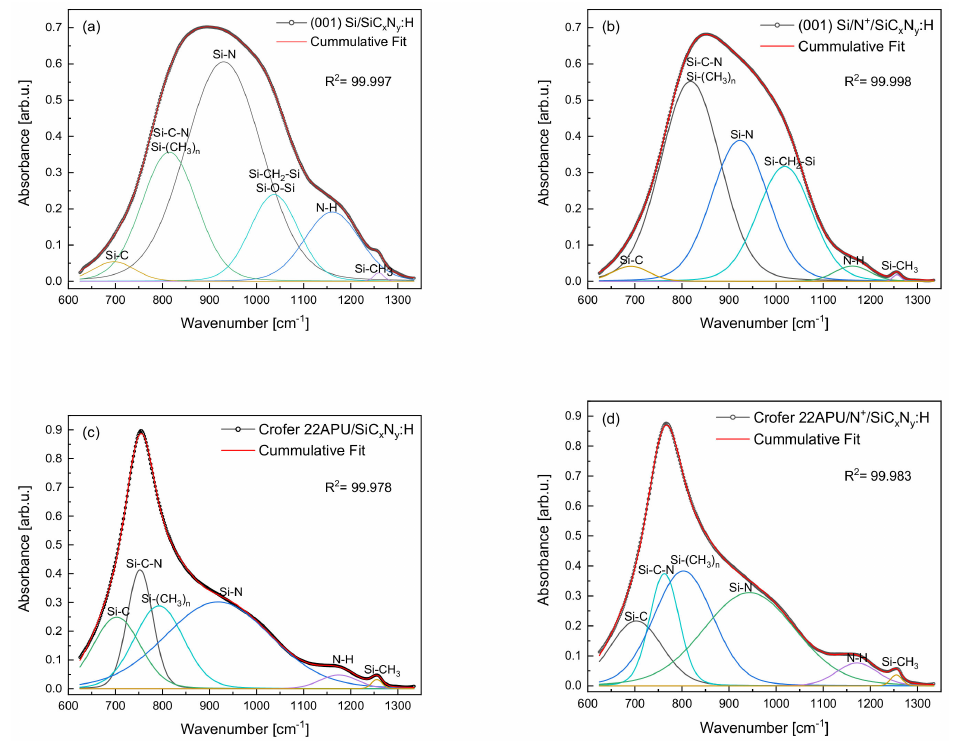
Figure 4. Deconvolution of FT IR spectra in the range of 600–1350 cm − 1 for ( a ) SiC x N y :H layer on (001) Si, ( b ) N + ion modification, and SiC x N y :H layer on (001) Si, ( c ) SiC x N y (H) layer on Crofer 22APU and ( d ) N + ion modification and SiC x N y :H layer on Crofer